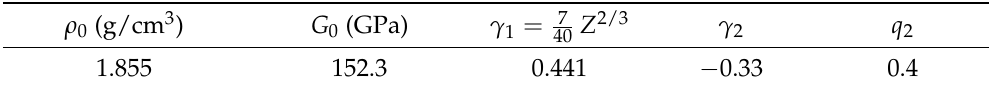
Table 2. Five parameters of the unified analytic melt-shear thermoelasticity model of Be associated with its shear modulus.